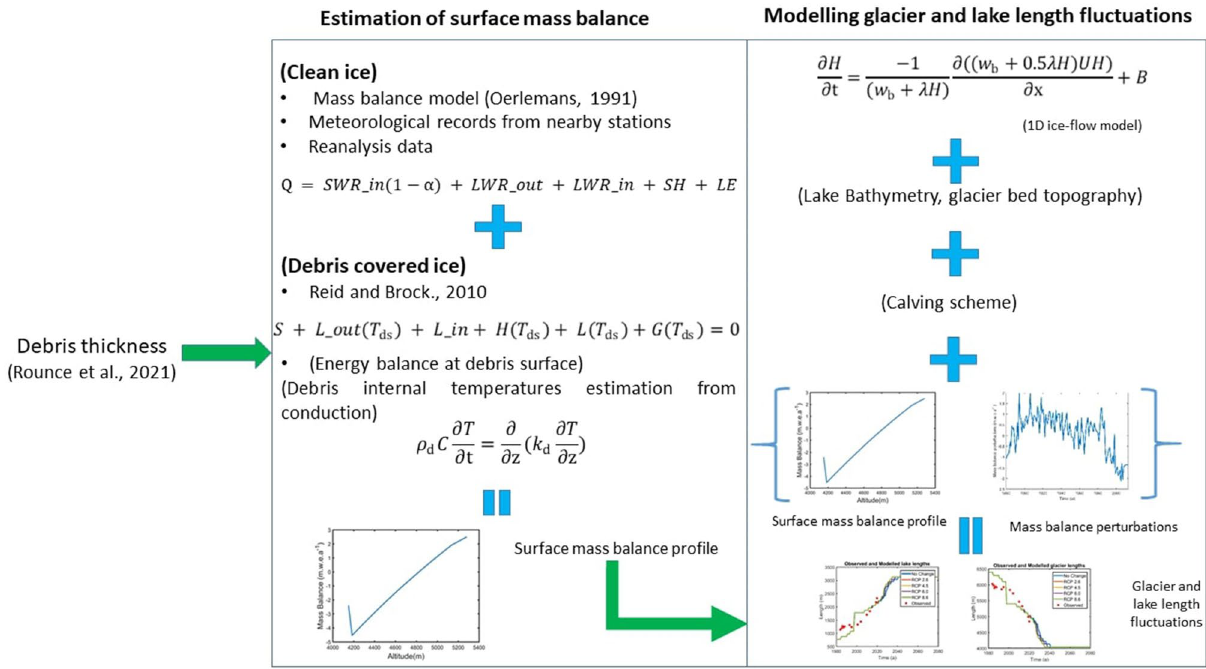
Figure 2. Schematic of the methodology used in this study. Starting from the left, the first block titled ‘Estimation of debris thickness’ briefly summarises how debris thickness was estimated; the second titled ‘Estimation of surface mass balance’ shows the approach used in estimating surface mass balance and finally the last block titled ‘Modelling glacier and lake length fluctuations’ shows the way in which the numerical ice flow model was used for simulating past retreat and past lake length fluctuations. The green arrows between the blocks indicate which variable from one block is used in the analysis of another block. The relevant equations used in each of the blocks have been shown in red colour. (URL: www. mathw orks.